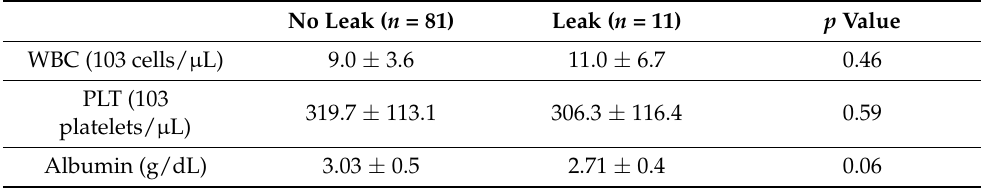
Figure 2. Area under the curve (AUC) by post-operative day (POD). The threshold value of 19.56 mg/dL on POD 3 was strongly exclusive of an AL, with an NPV of 98%. A threshold value of 12.5 mg/dL on POD 5 had an NPV of 100%. The PPV trended upward from day to day, reaching 100% on POD 5 for a threshold value of 12.5 mg/dL. WBC and PLT levels on POD 3 did not show a statistically significant difference between the AL and no-AL groups. The albumin level on POD 3 was lower in the AL group with borderline significance (see Table 4). Table 4. Other inflammatory markers on POD